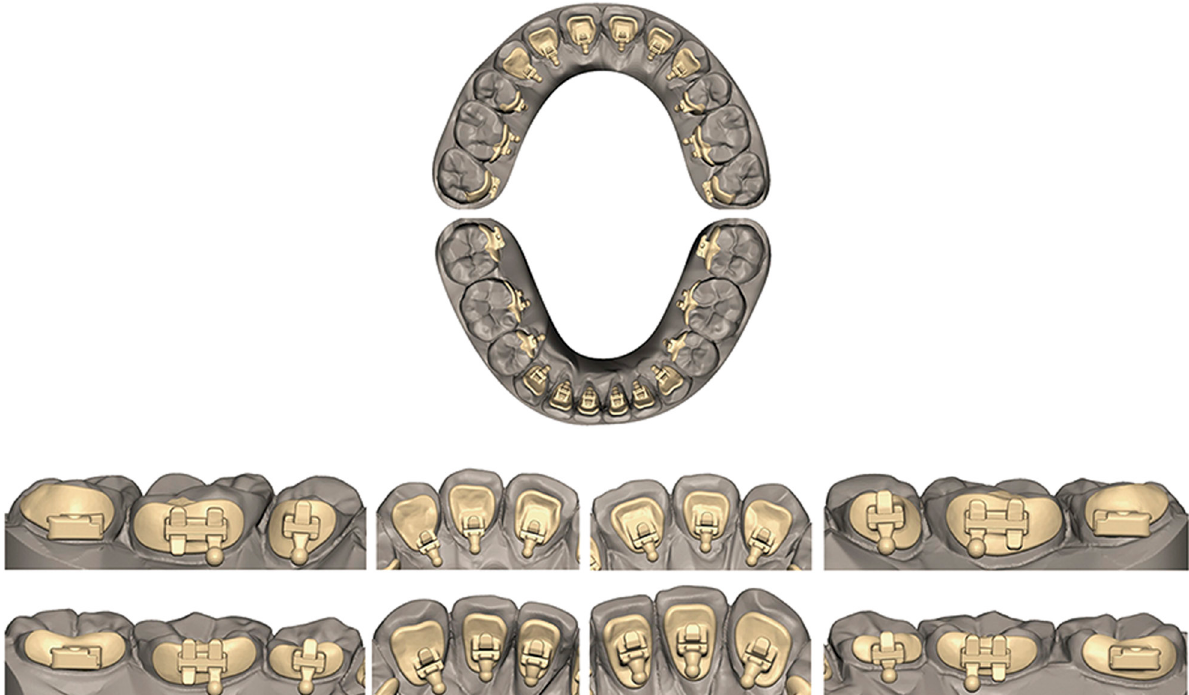
Figure 5. The lingual bracket system: 0.018”slot, vertical slots in the anterior brackets and horizontal slots in the posterior brackets.